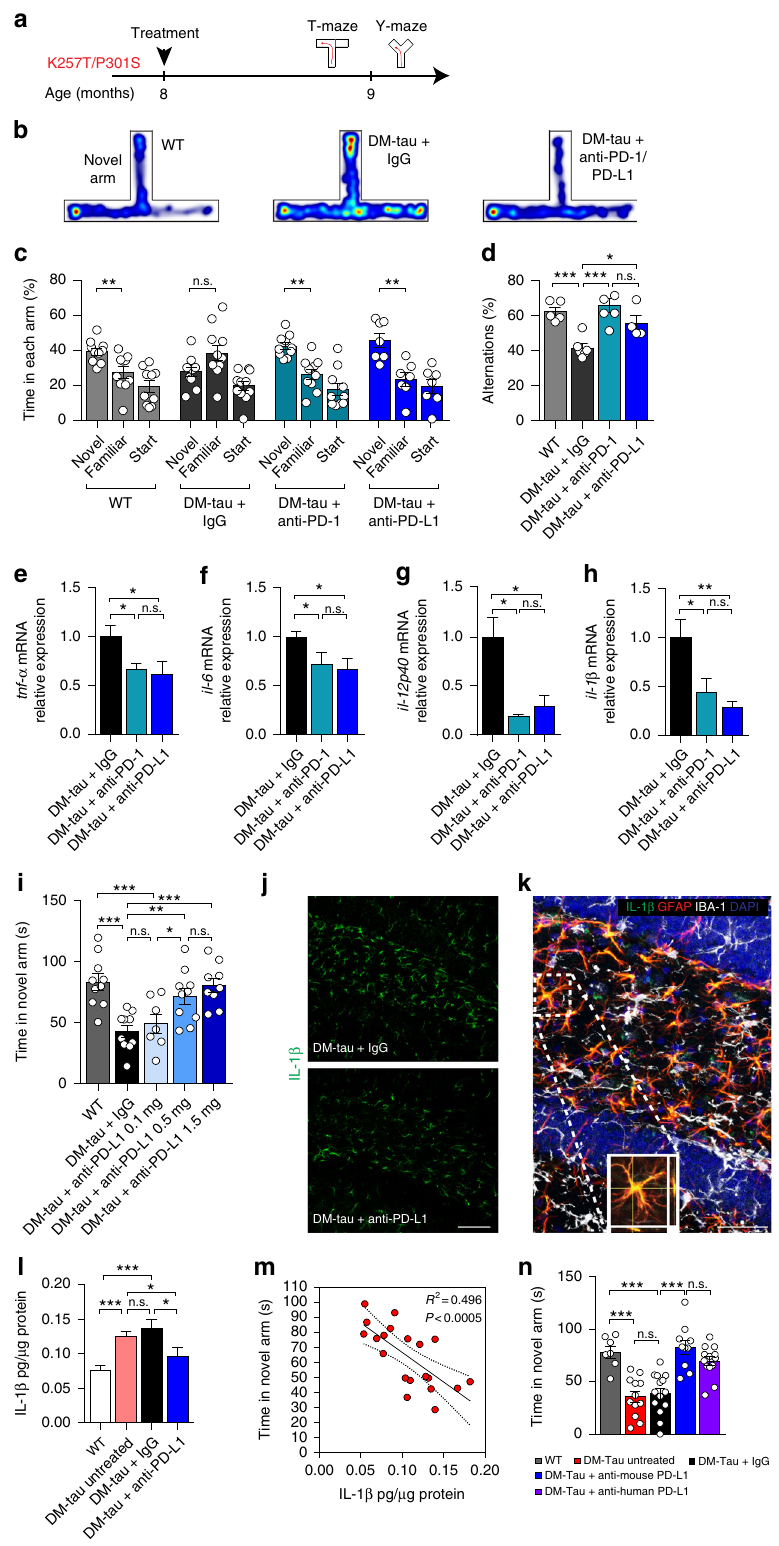
spleens of DM-hTAU mice 2 weeks after the anti-PD-L1 antibody administration revealed increased levels of effector memory T cells (T EM ; CD44 + CD62L low ) relative to those in IgG-treated mice (Fig. 5a, b), as evaluated by fl ow cytometry analysis. We further analyzed, by fl ow cytometry, in the DM-hTAU mice whether the treatment facilitated recruitment of monocyte- NATURE COMMUNICATIONS| (2019) 10:465